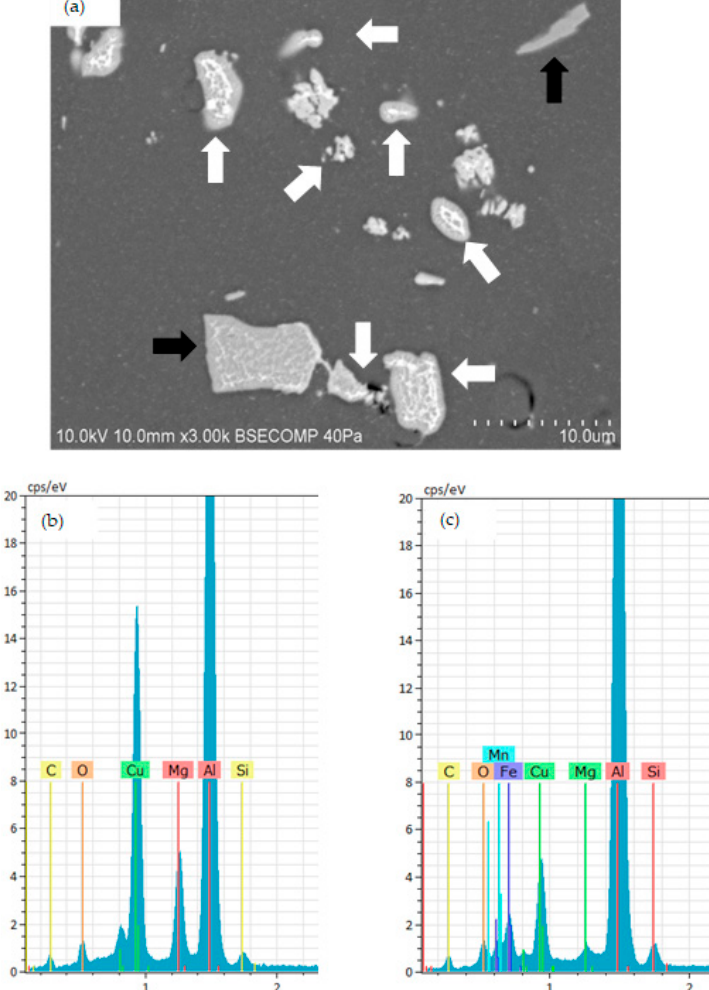
Figure 2. ( a ) Scanning electron microscopy (SEM) image of the main phases identified in alloy AA2024-T3; ( b ) Energy-dispersive X-ray analysis (EDX) spectrum of Al(Cu,Mg) particle (white arrows); ( c ) EDX spectrum of Al-Cu-Fe-Mn-(Si) particle (black arrows).